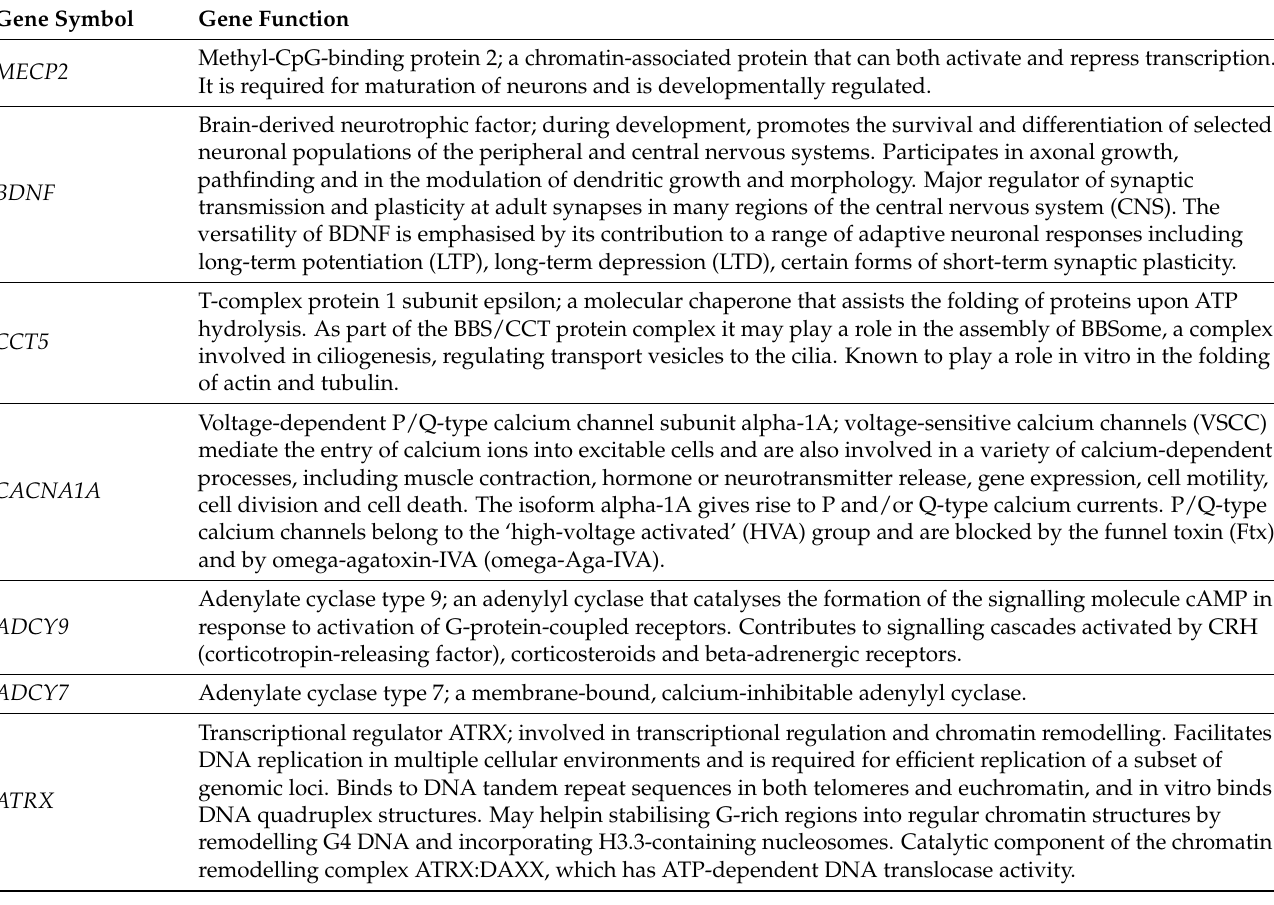
Table 2. Hub genes and functions. Information adapted from